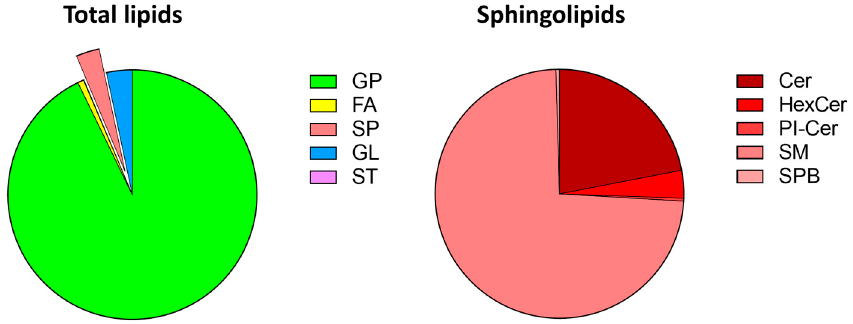
Figure 4. Lipid composition of zebrafish embryos. Untargeted lipidomic MS analysis of zebrafish embryos at 72 hpf identified 1377 lipid species. The relative amounts of the major classes of lipids are shown in the corresponding pie charts. Lipids were grouped into categories according to the LIPID MAPS consortium nomenclature [104]. Cer, ceramide; FA, fatty acyls; GL, glycerolipids; GP, glycerophospholipids; HexCer, hexosylceramides; PI-Cer, inositolphosphorylceramides; SM, sphingomyelins; SPB, sphingoid bases; SP, sphingolipids; ST, sterols.